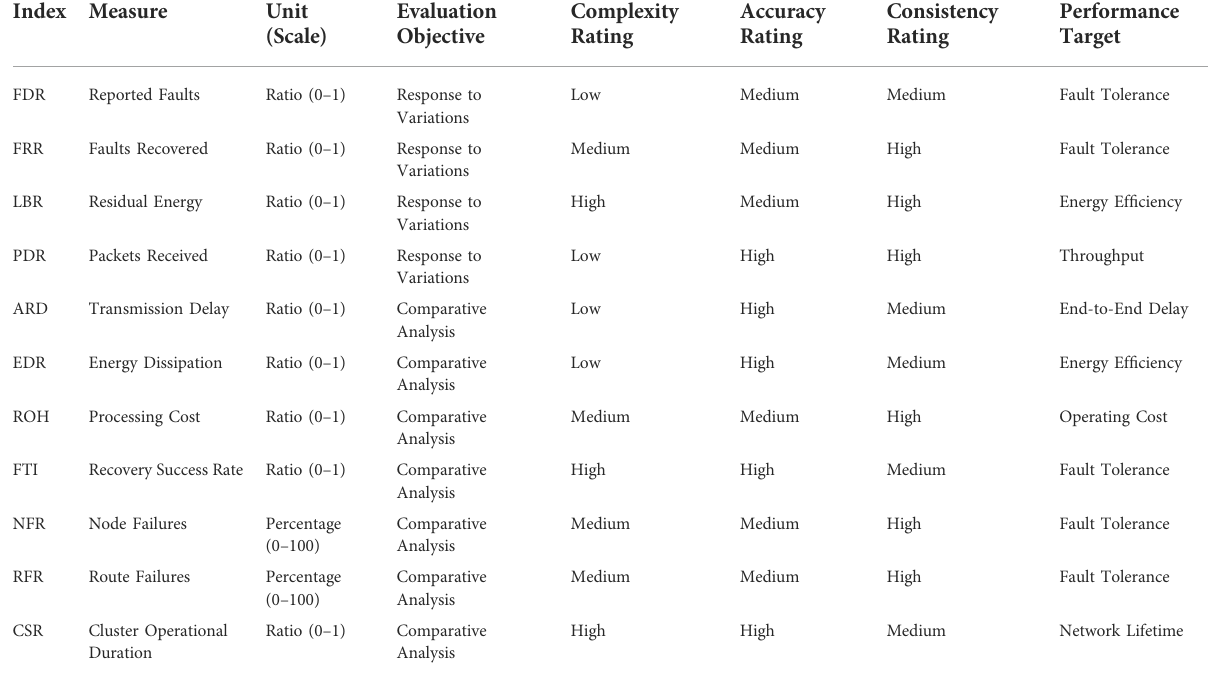
TABLE 3 Conundrum matrix evaluation for performance